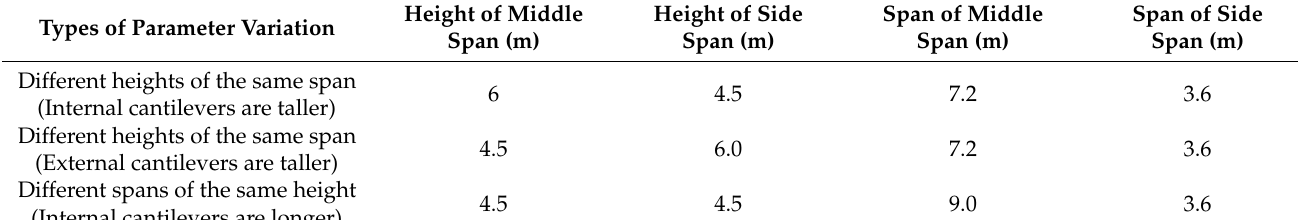
Table 1. Types and related parameters of the units with variable parameters.